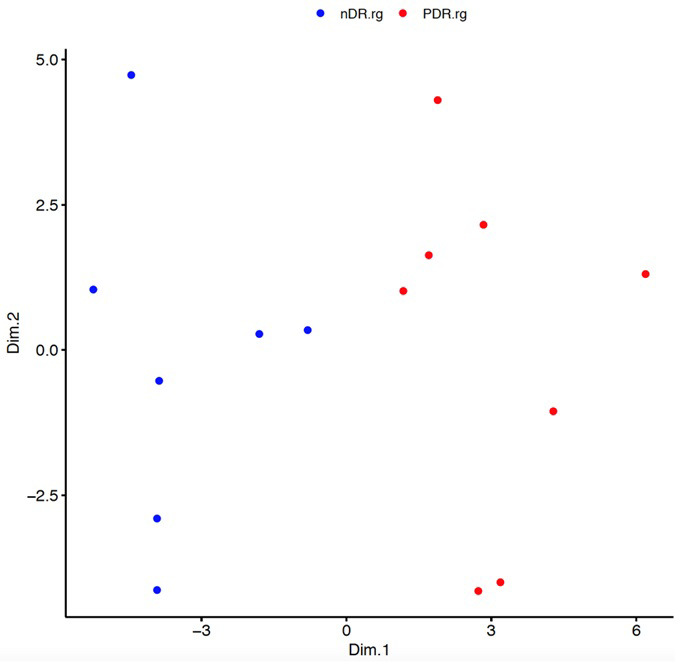
Multidimensional scaling based on differential response to glucose (rg).Each point represents a single study subject; individuals with proliferative diabetic retinopathy (PDR, red, n = 8) and individuals with diabetes without retinopathy (nDR, blue, n = 7). The first coordinate (Dim.1, x-axis) is correlated with subject retinopathy status (RGpdr–ndr, p=3×10−6). Source and code files for this plot are available in Figure 2—source data 2, 3, 4, and 5 and Source code 6.